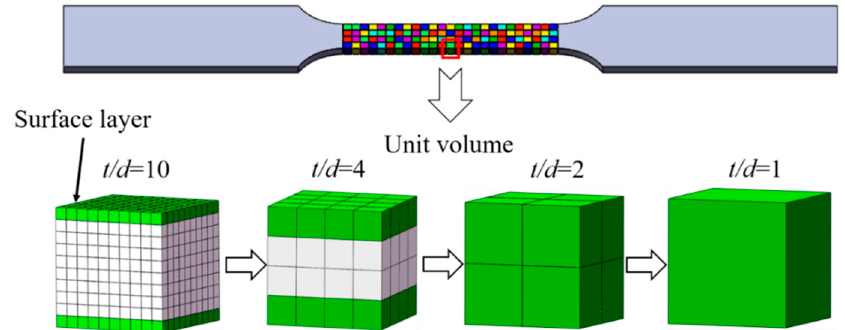
Figure 4. Grain number per unit volume and surface layer grains with decreasing thickness/average grain sizes (t / grain sizes (t/d).